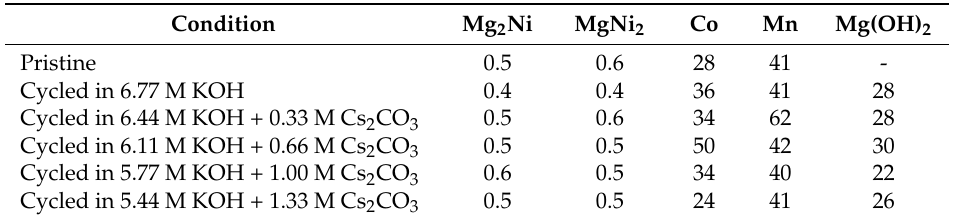
Figure 5. X-ray diffraction (XRD) patterns of the pristine and cycled AR3 in the 6.77 M KOH, 6.44 M KOH + 0.33 M Cs 2 CO 3 , 6.11 M KOH + 0.66 M Cs 2 CO 3 , 5.77 M KOH + 1.00 M Cs 2 CO 3 , and 5.44 M KOH + 1.33 M Cs 2 CO 3 electrolytes. Note: Peaks marked as “A” represent the microcrystalline/amorphous components of MgNi 2 and Mg 2 Ni; peaks marked as “1” and “2” represent metallic Mn and Co, respectively, and peaks marked as “3” represent Mg(OH) 2 . Table 4. Crystallite sizes in nm of the Mg 2 Ni, MgNi 2 , Co, Mn, and Mg(OH) 2 phases obtained from the XRD patterns in Figure 5.